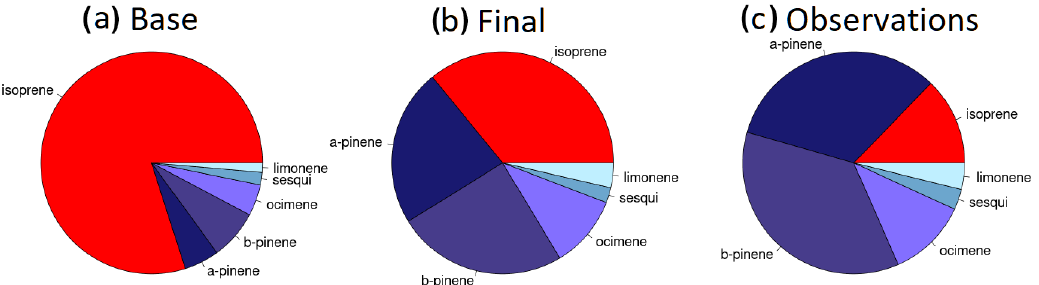
Figure 7. Pie charts of the distribution of BVOCs in the observations, the base case, and the final case. In the species presented here, every species represents only the species named apart from ocimene. Ocimene is the sum of myrcene and ocimene in the model, and the same sum is presented for the